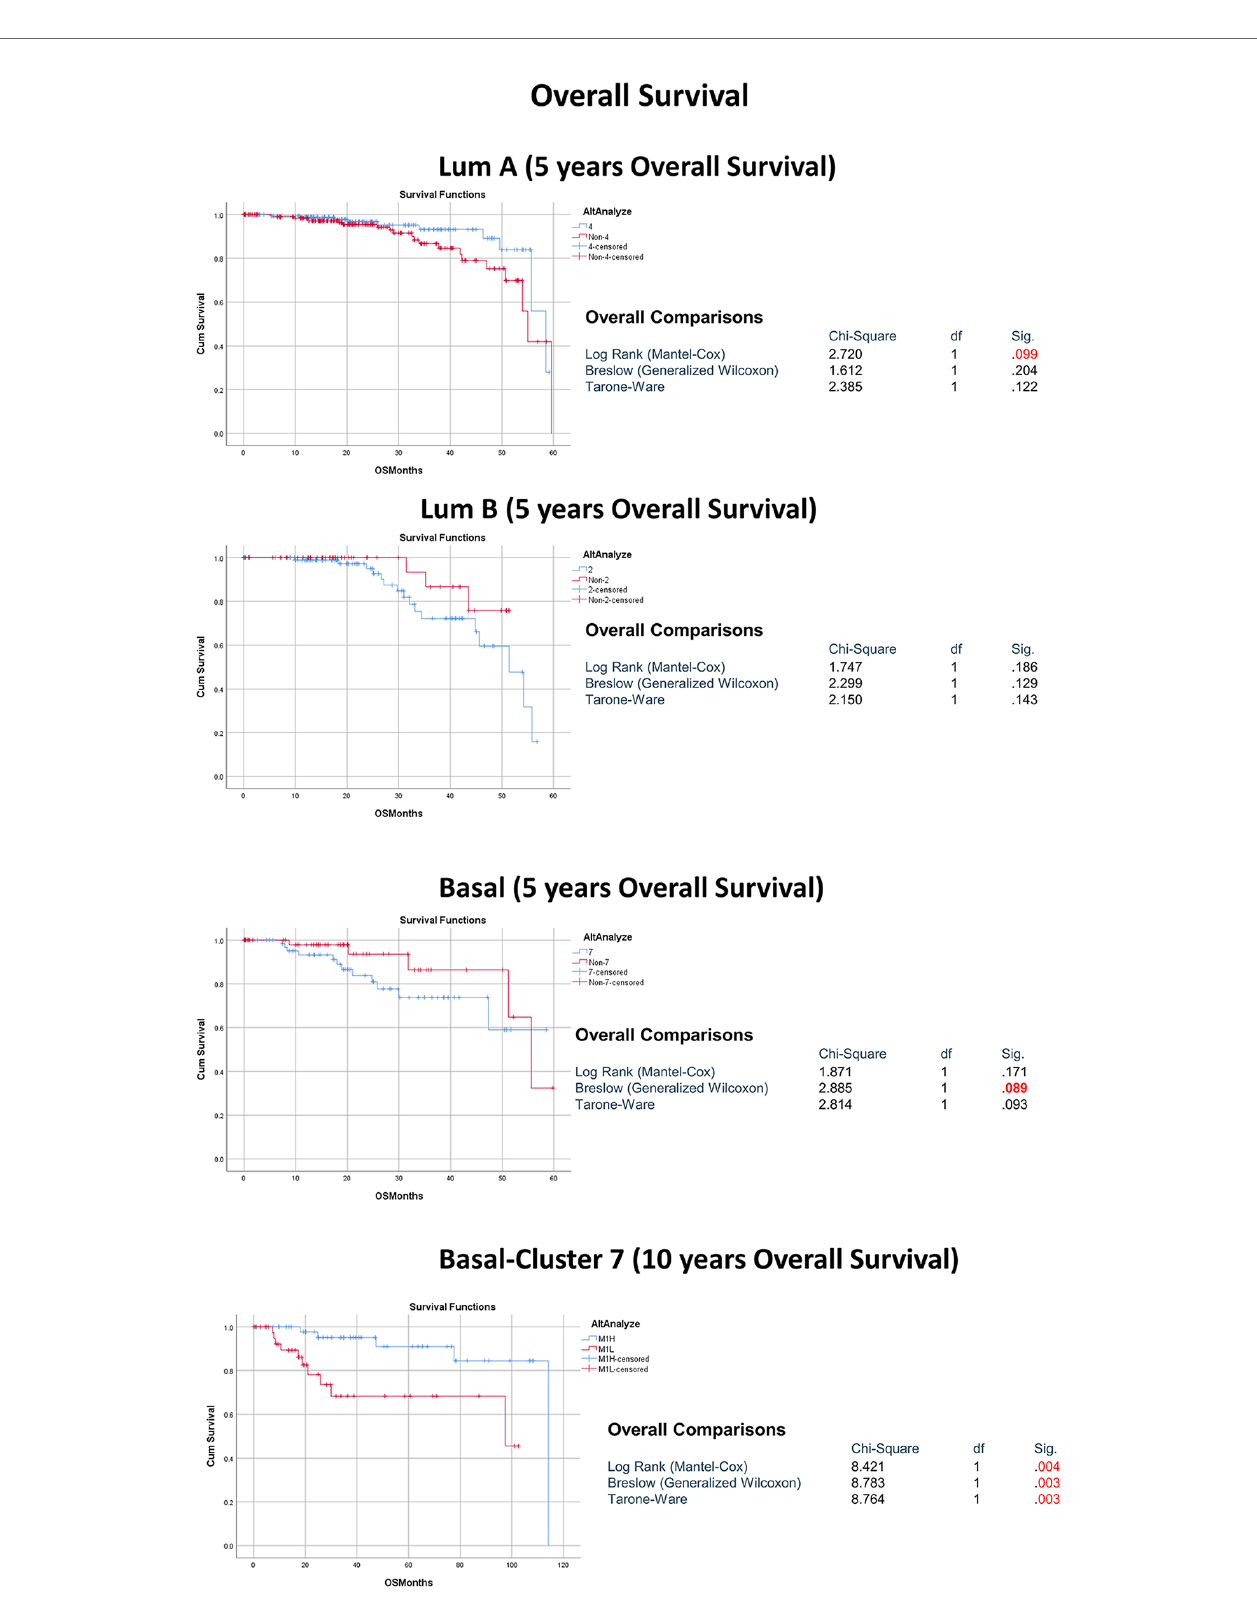
FIGURE 3 | The association between the dominant sub-cluster within each molecular subtype and patient